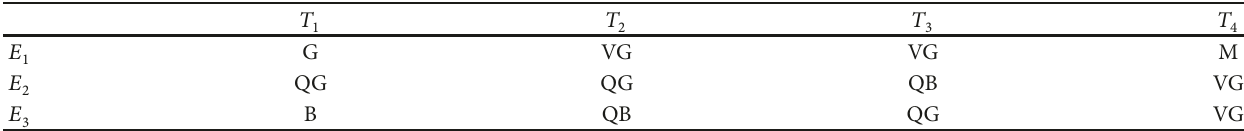
̃𝐿 provided by the expert Ζ 2 .